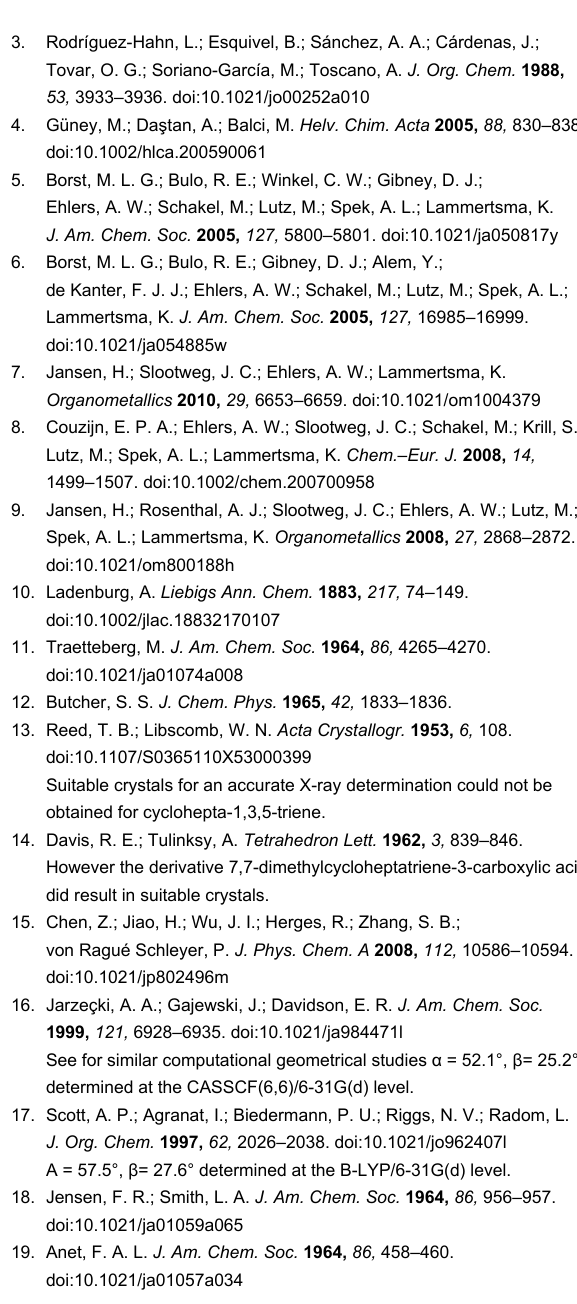
Scheme 7: Phosphinidene generation from metal-complexed benzophosphepine 33 .